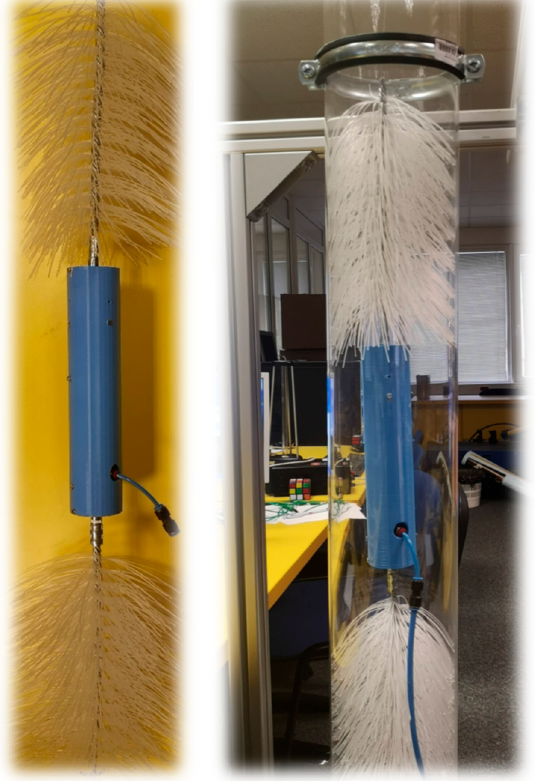
Figure 5. The developed chimney robot